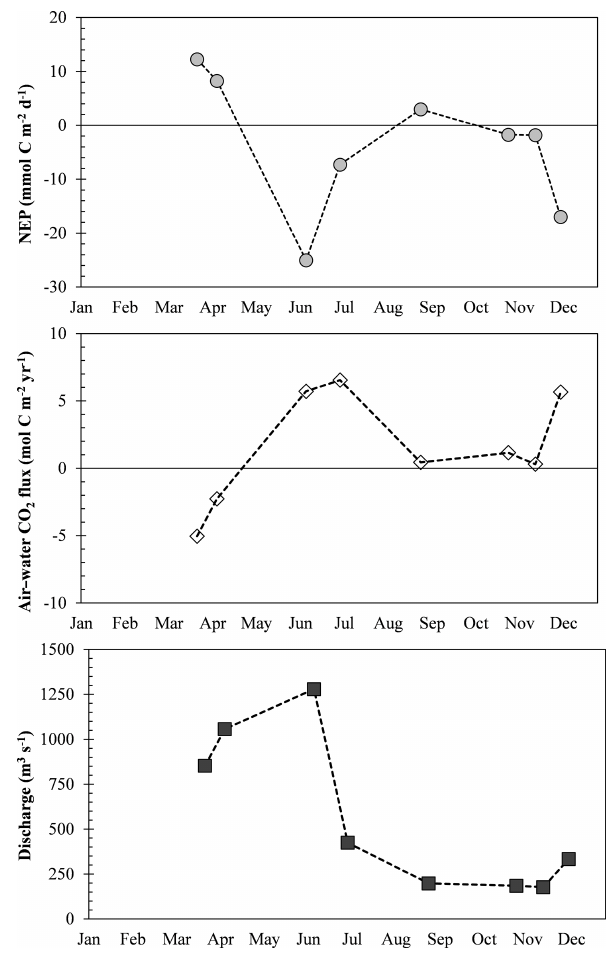
Figure 9. Seasonal variations of net ecosystem production, air– water CO 2 fluxes, and discharge in the Delaware Estuary. Note the different scales used for each plot. Discharge is defined as the aver- age of the total discharge to the estuary recorded during each cruise period including discharges recorded 10 days prior to the